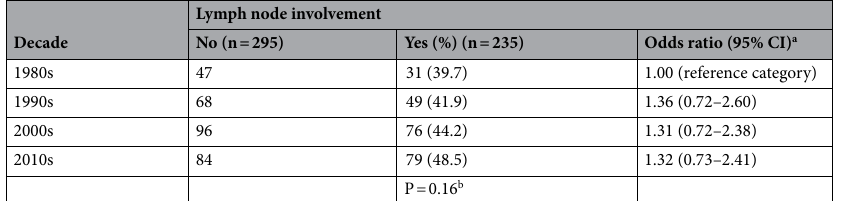
Table 2. Association of time period with the likelihood of lymph node involvement in patients with vulvar squamous cell carcinoma living in northern Italy. Analysis was restricted to patients undergoing lymph node dissection (n = 530). a Simultaneously adjusted for patient age, tumour size, disease location, depth of stromal invasion and number of lymph nodes dissected. b Chi-square test for trend. CI, confidence interval.